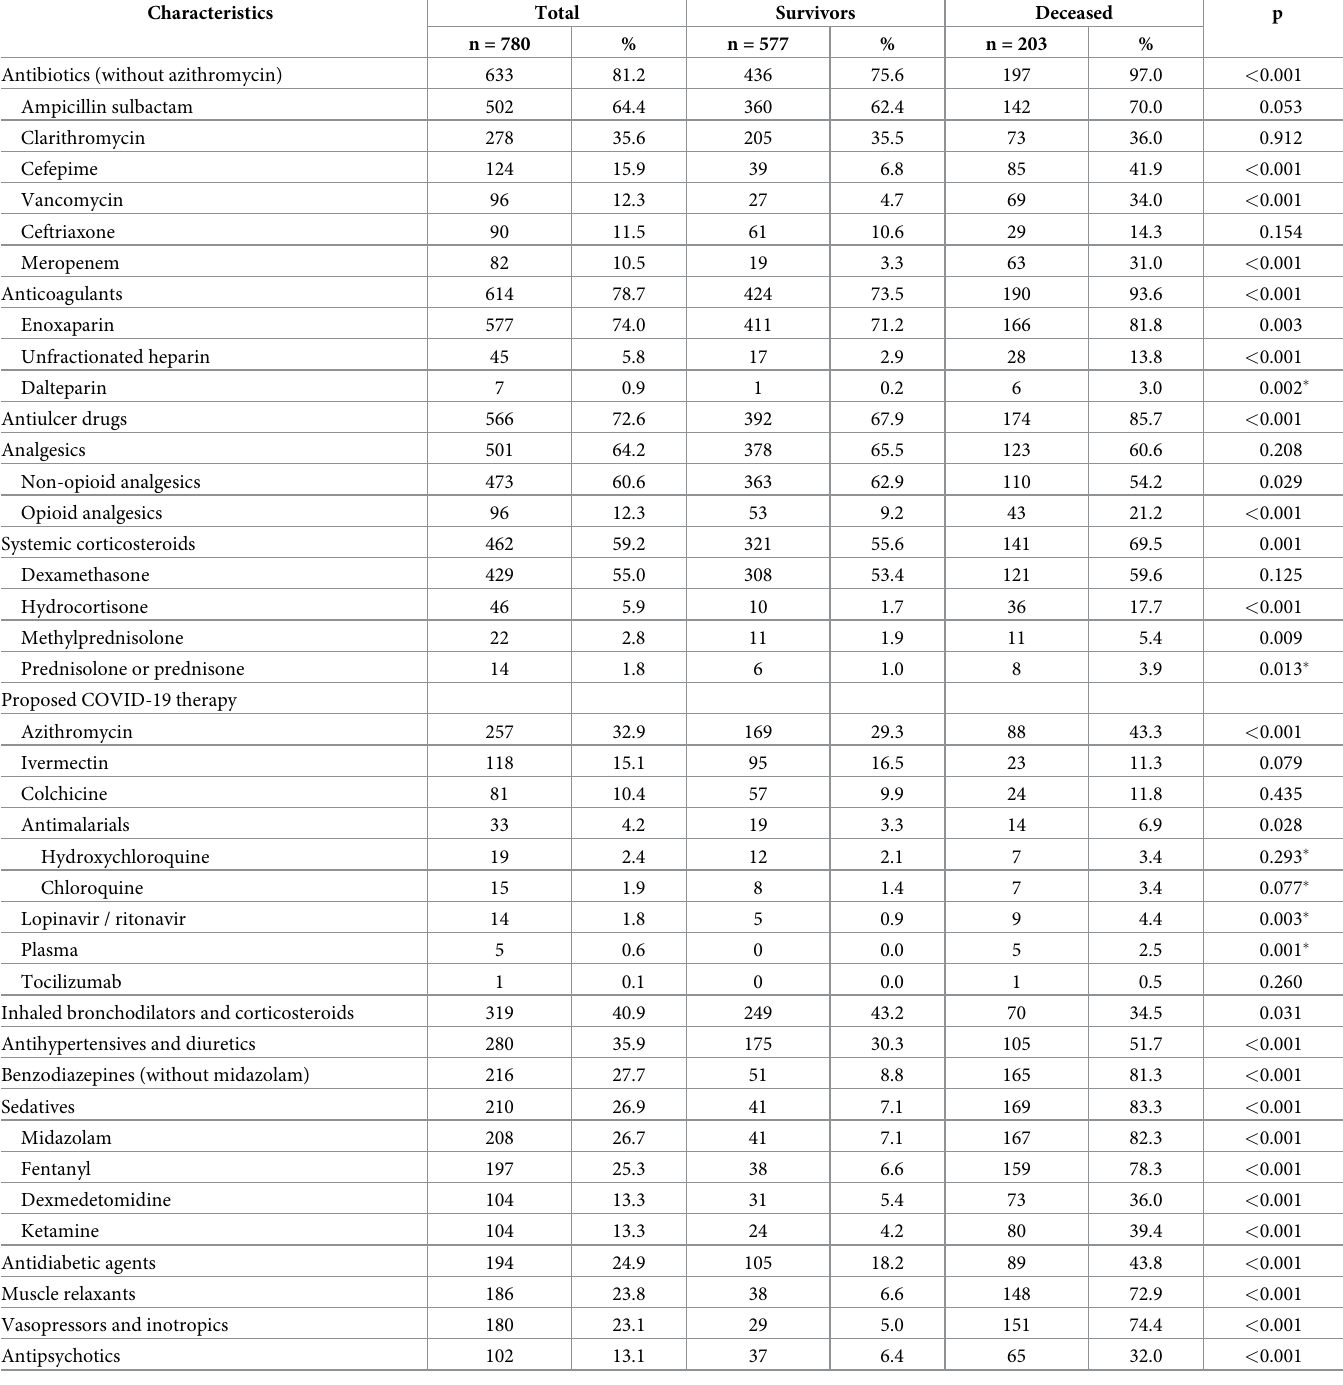
Table 4. Pharmacological management received during medical care among patients who survived and died, infected by